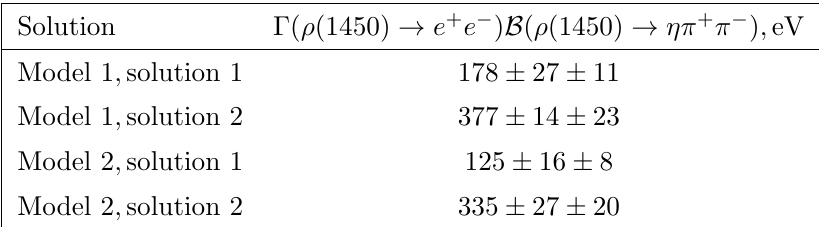
Table 5 . The (cid:0)( (cid:26) (1450) ! e + e (cid:0) ) B ( (cid:26) (1450) ! (cid:17)(cid:25) + (cid:25) (cid:0) ) products obtained from di(cid:11)erent (cid:12)ts, which correspond to solutions 1{2 in each of the two models. The (cid:12)rst uncertainty in each product is statistical, the last one is systematic.